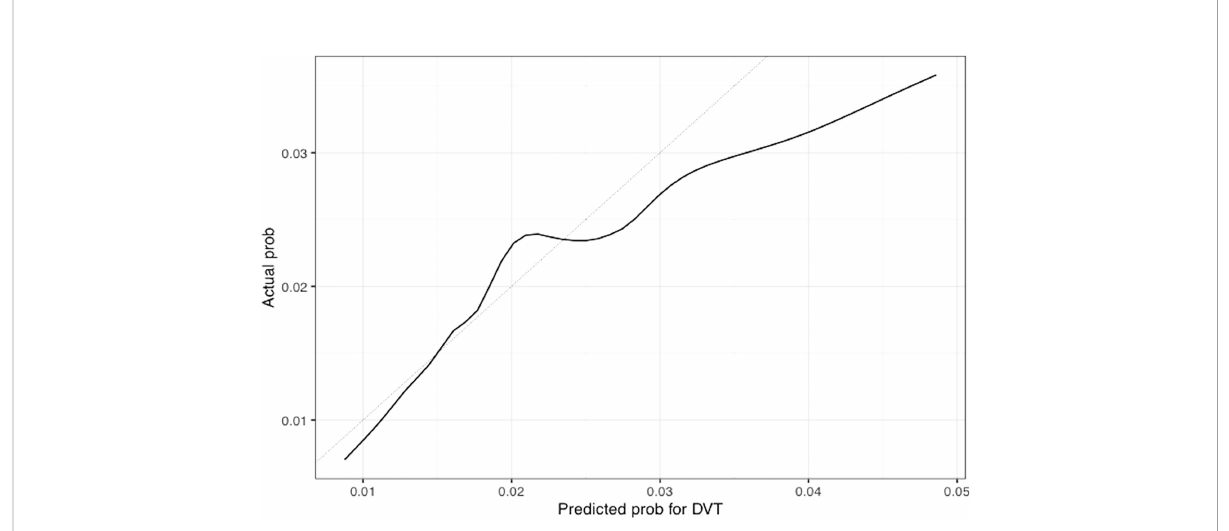
FIGURE 6 Calibration plot of the nomogram for predicting 1-year overall probability for DVT in patients with GCA. Nomogram-predicted probability for DVT is plotted on the x-axis while actual probability is plotted on the y-axis; The grey line represents the ideal